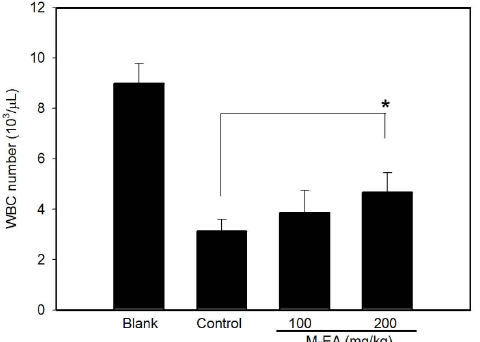
Figure 7. Rise in the WBC level of M-EA treated daunoblastina-induced leucopenic mice. Blank group: The sterile water orally administered and normal saline i.p. once. Induced group: The sterile water orally administered and daunoblastina, i.p. Test groups: The M-EA at 100 and 200 mg/kg orally administered and daunoblastina i.p . Each group contained six mice. * p <